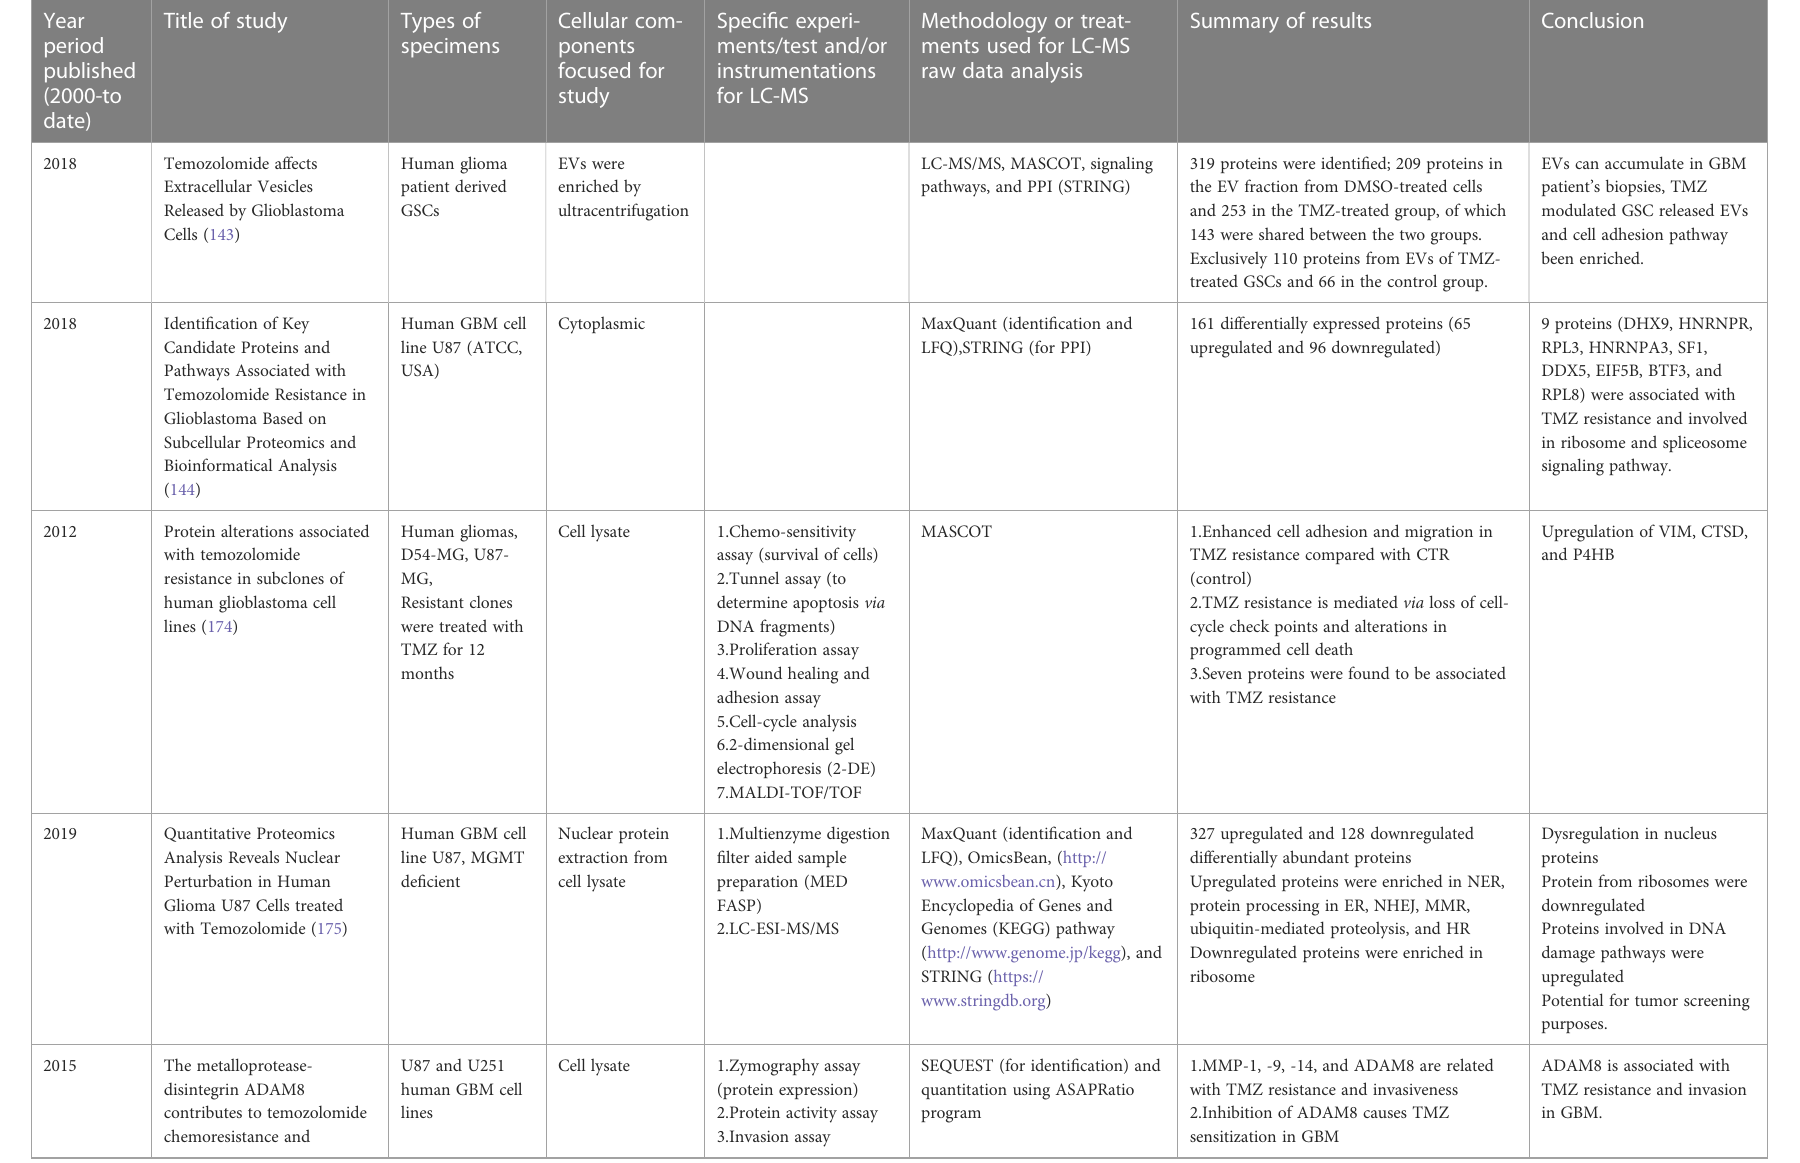
TABLE 2 List of selected studies conducted (from year 2000 to date) to understand the TMZ resistance in human GBM and other types of cancers (TMZ treatment) using LC-MS-based proteomics